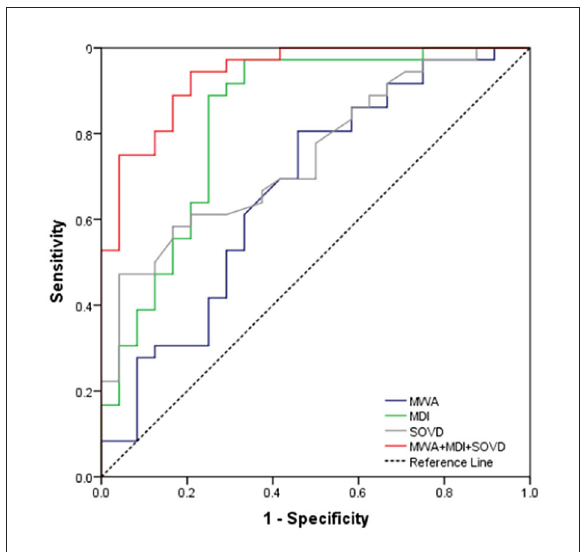
FIGURE4 ROC curve for MWA alone, MDI alone, SOVD alone, and combining the above three as a predictor for the occurrence of